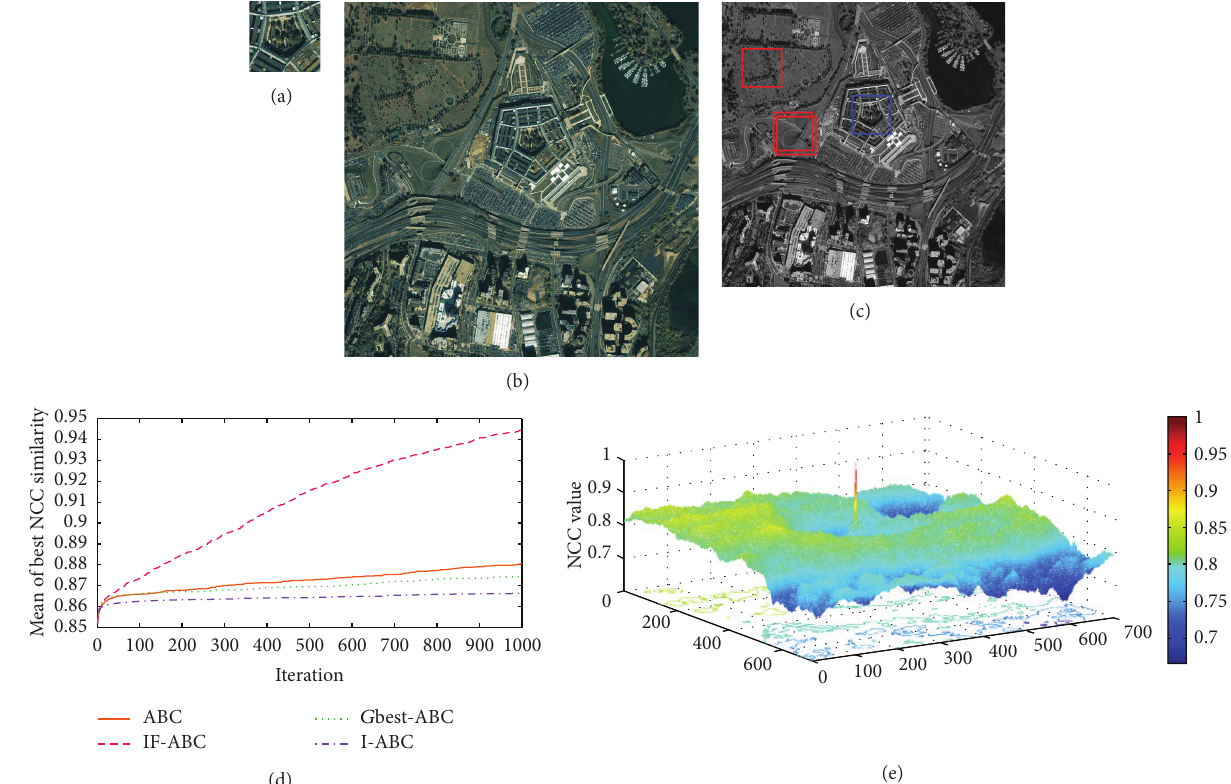
Figure 6: Ideal template matching case 4: satellite imagery of the Pentagon. (a) Predefined template image (116 × 114); (b) source image (820 × 820); (c) ground matching truth (blue box) and most common false matching results (red boxes); (d) comparative evolution curves of four ABC algorithms; (e) surface illustration of searching space.